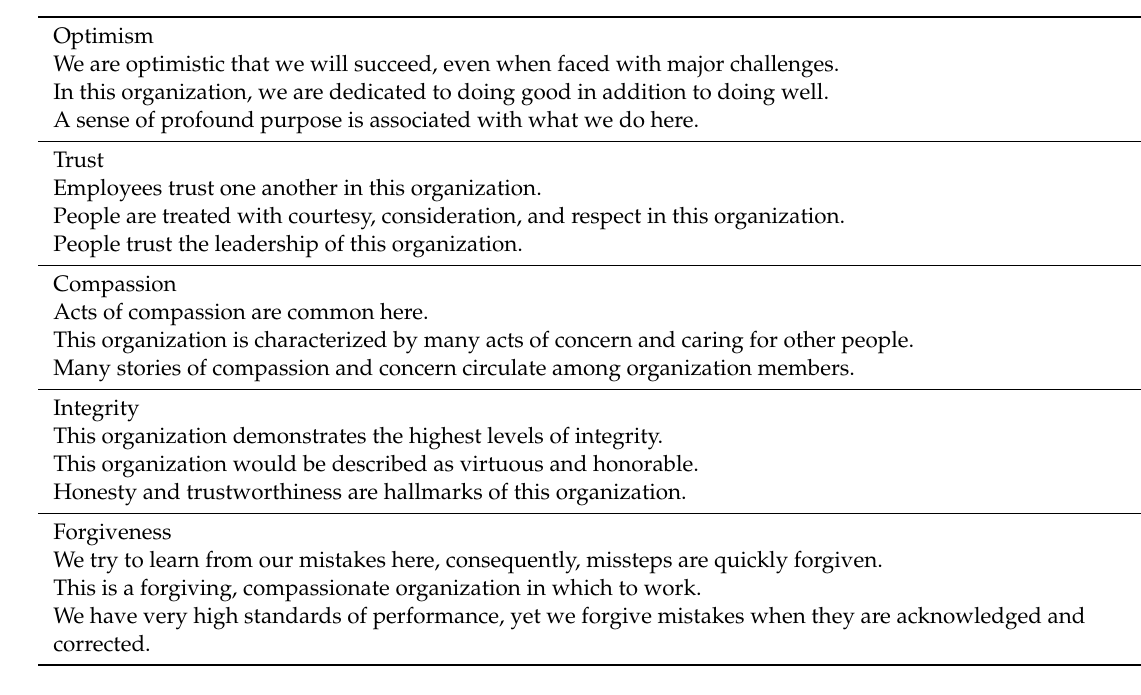
Table 1. The perceived organizational virtuousness